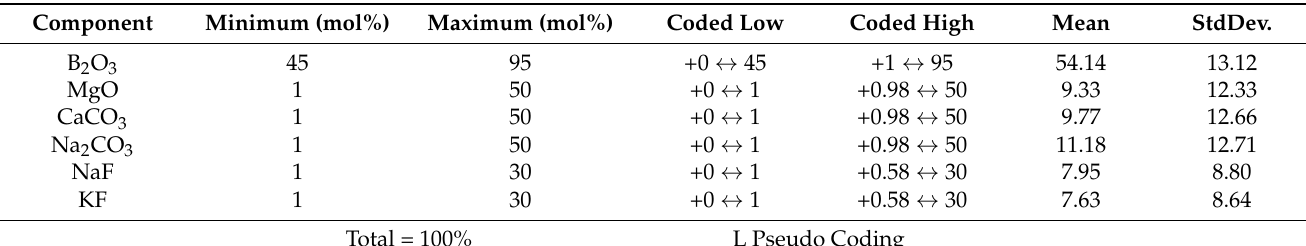
Table 1. Design of the mixture components.